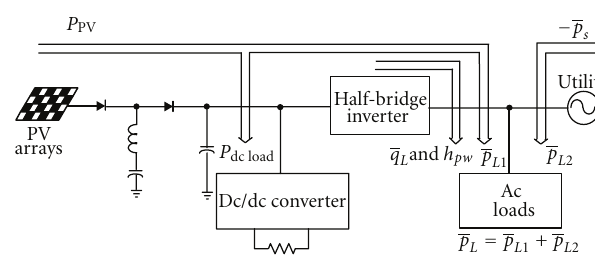
Figure 9: Illustration of power flow during the interval of medium